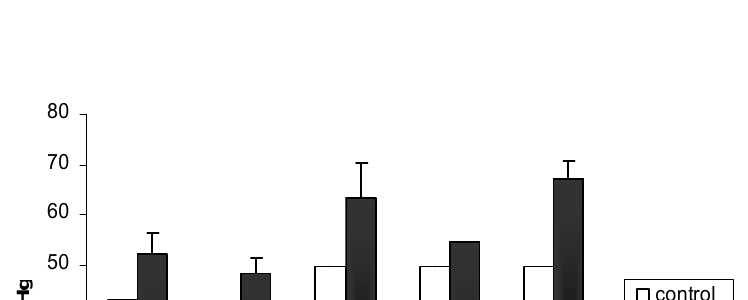
Figure 1. Mean arterial oxygen tension (PO inoculated with Leptospira interrogans Icterohaemorrhagiae and their respective control group.